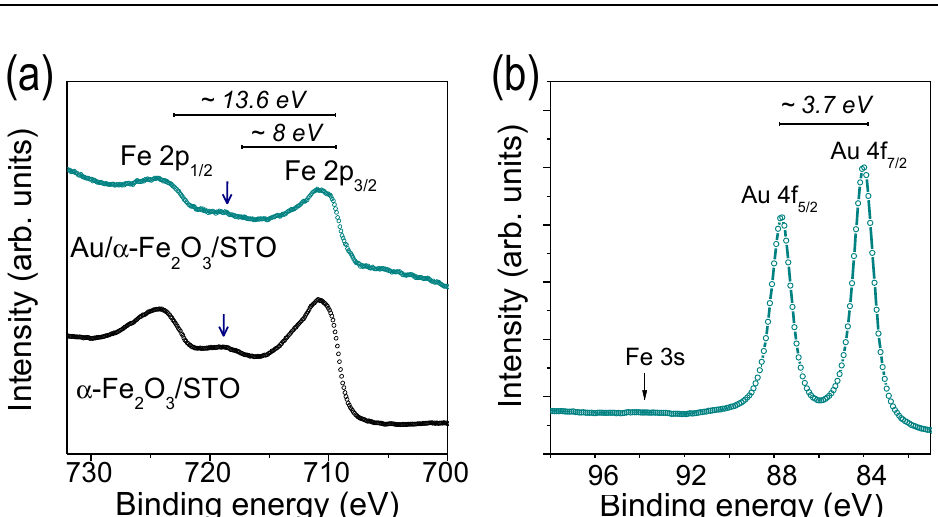
Figure 7. XPS measurements performed on the ( a ) Fe 2p core level of the α -Fe 2 O 3 layer and the Au/ α - Fe 2 O 3 bilayer grown on STO(111) substrates and ( b ) Au 4f core level of the Au/ α -Fe 2 O 3 bilayer grown on STO(111) substrate. Lower signal is collected on the Fe 2p core level for the Au/ α -Fe 2 O 3 bilayer than for the α -Fe 2 O 3 layer.